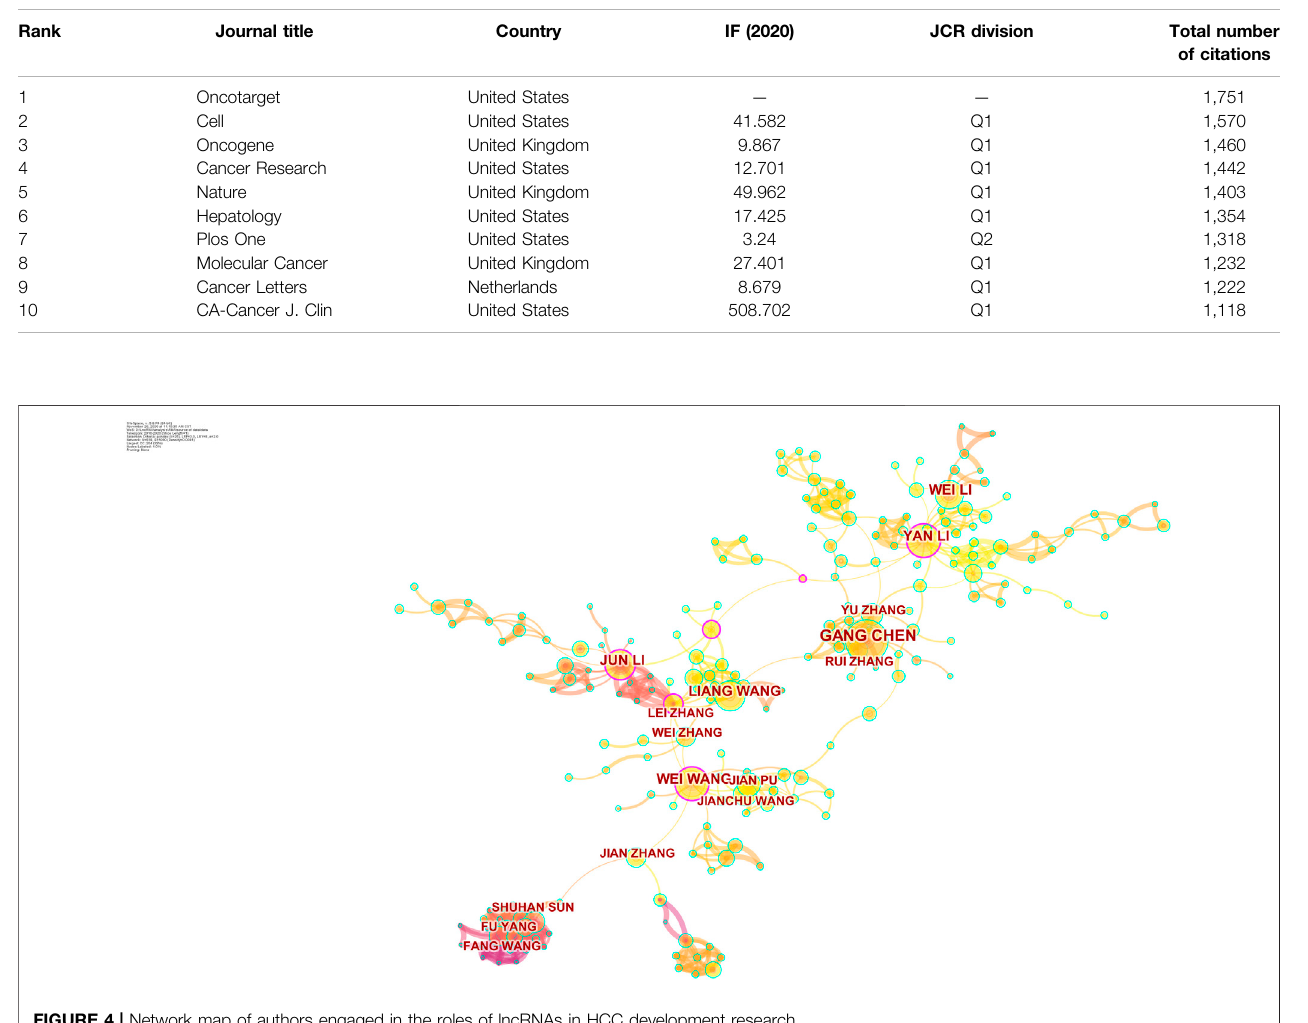
FIGURE 4 | Network map of authors engaged in the roles of lncRNAs in HCC development research.